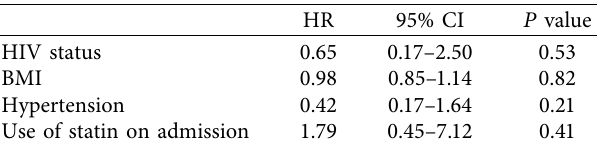
Table 5: Multivariate logistic regression analysis of 1-year